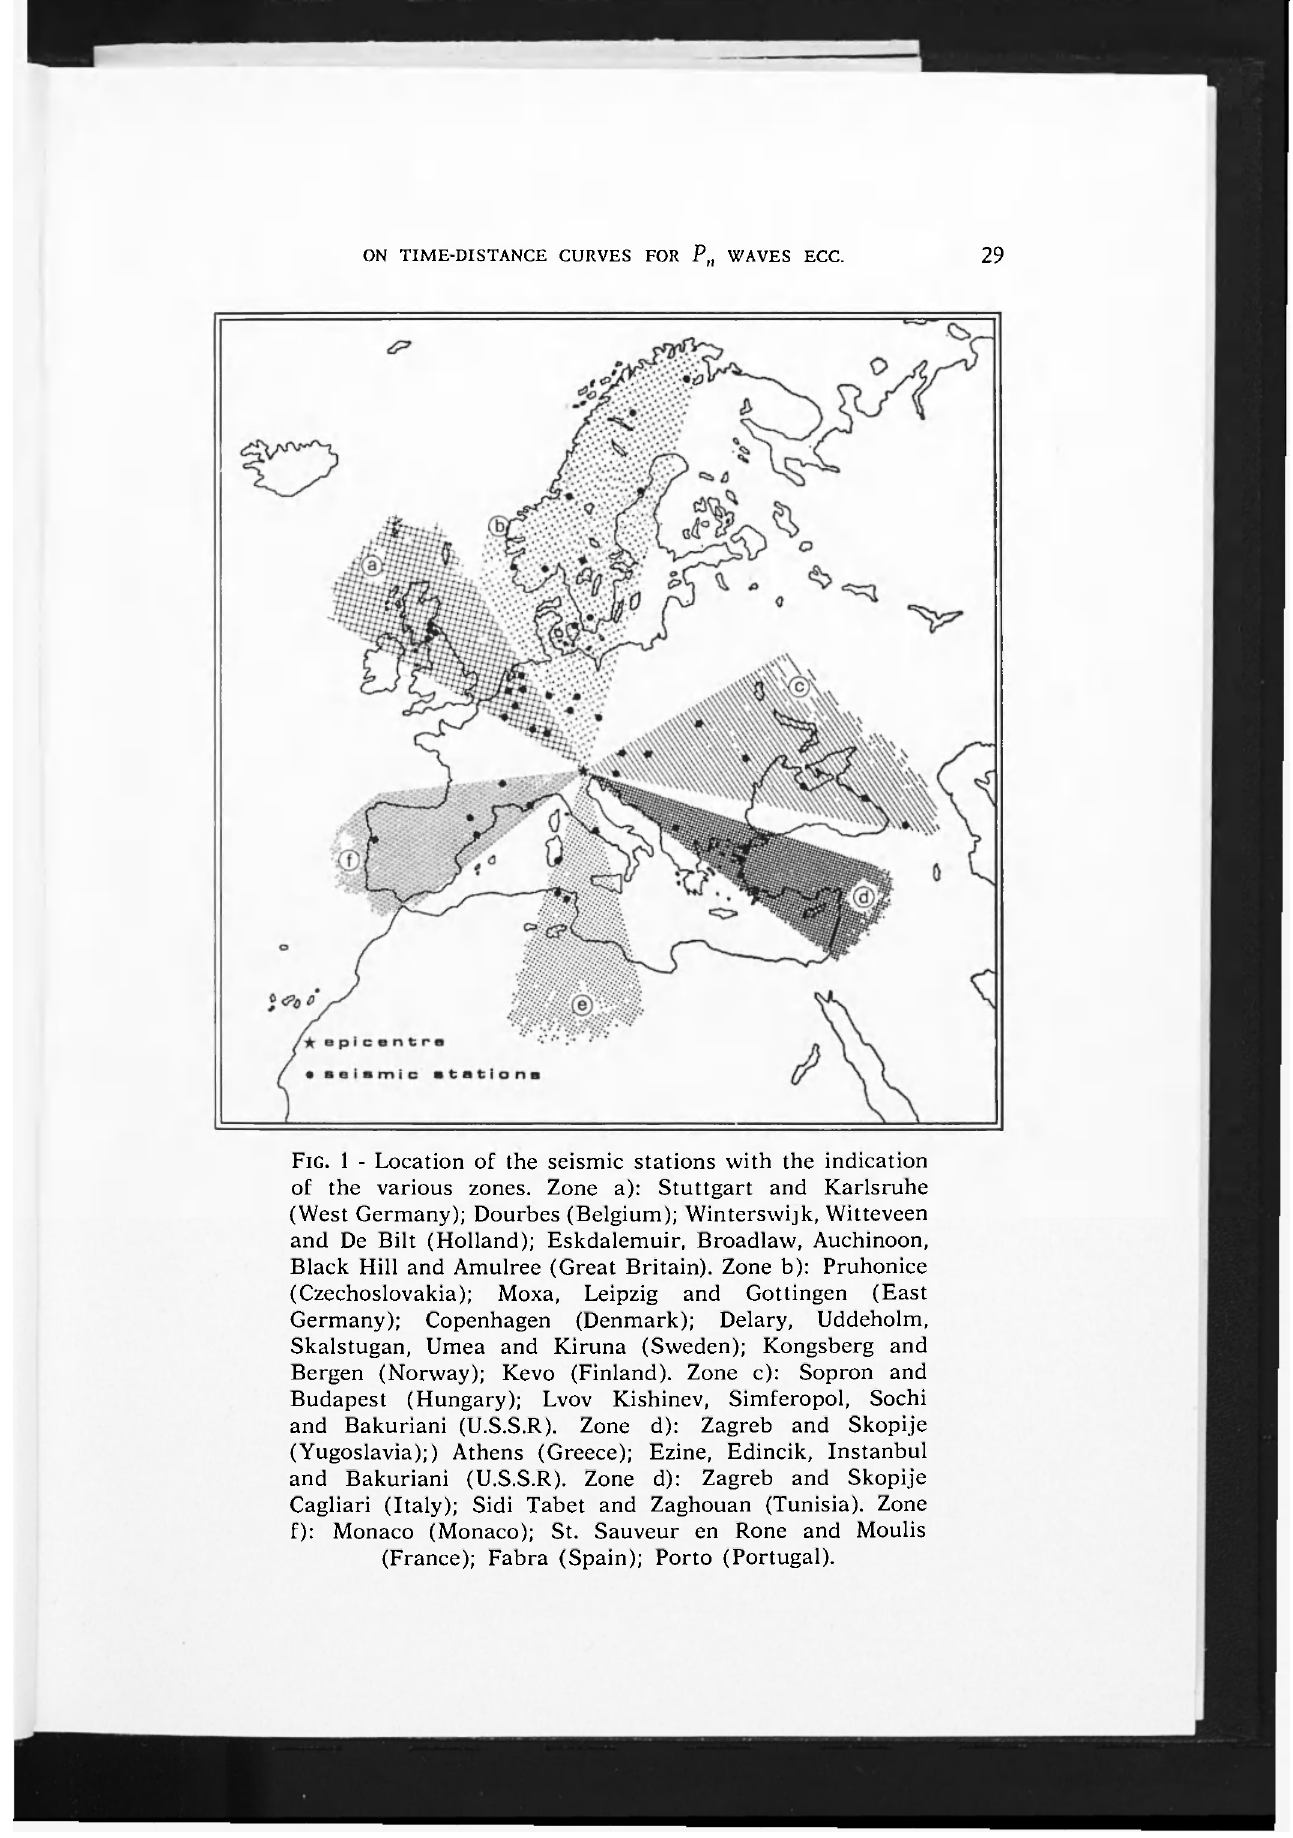
FIG. 1 - Location of the seismic stations with the indication of the various zones. Zone a): Stuttgart and Karlsruhe (West Germany); Dourbes (Belgium); Winterswick, Witteveen and De Bilt (Holland); Eskdalemuir, Broadlaw, Auchinoon, Black Hill and Amulree (Great Britain). Zone b): Pruhonice (Czechoslovakia); Moxa, Leipzig and Gottingen (East Germany); Copenhagen (Denmark); Delary, Uddeholm, Skalstugan, Umea and Kiruna (Sweden); Kongsberg and Bergen (Norway); Kevo (Finland). Zone c): Sopron and Budapest (Hungary); Lvov Kishinev, Simferopol, Sochi and Bakuriani (U.S.S.R). Zone d): Zagreb and Skopije (Yugoslavia);) Athens (Greece); Ezine, Edincik, Instanbul and Bakuriani (U.S.S.R). Zone d): Zagreb and Skopije Cagliari (Italy); Sidi Tabet and Zaghouan (Tunisia). Zone f): Monaco (Monaco); St. Sauveur en Rone and Moulis (France); Fabra (Spain); Porto